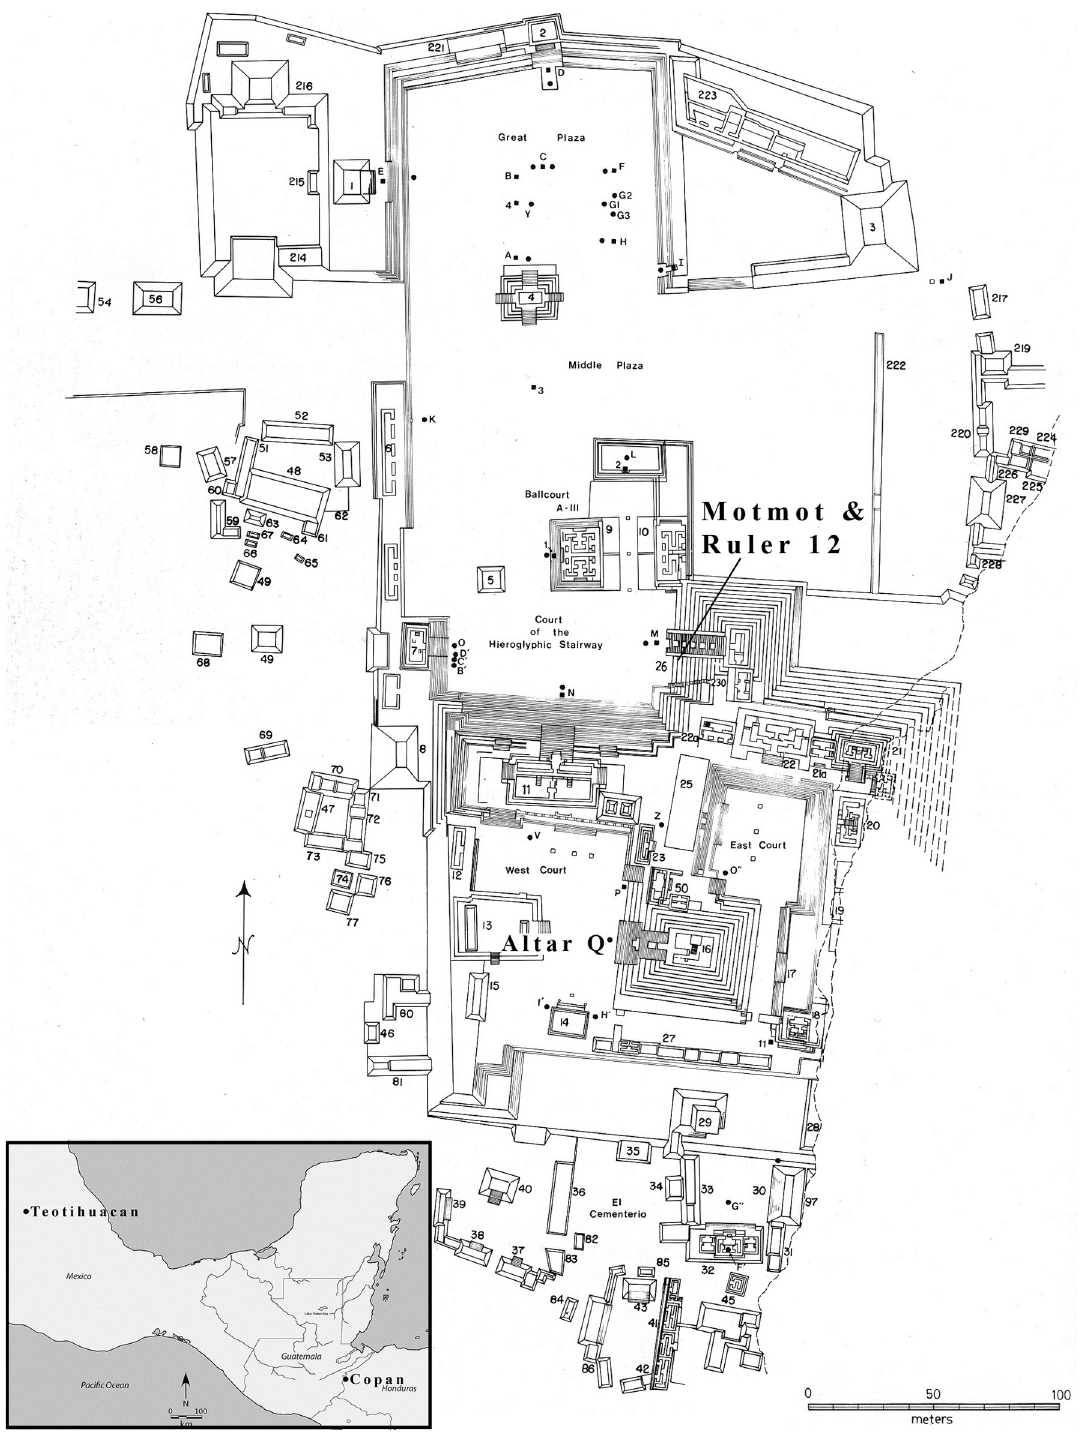
Fig 1. Map of the Principal Group at Copan highlighting location where Altar Q, Motmot burial, and Ruler 12 burial were excavated (modified from Fash 1991:Fig 8 under a CC BY license, with permission from Fash, original copyright 1991) and inset map of Mesoamerica highlighting location of Copan and